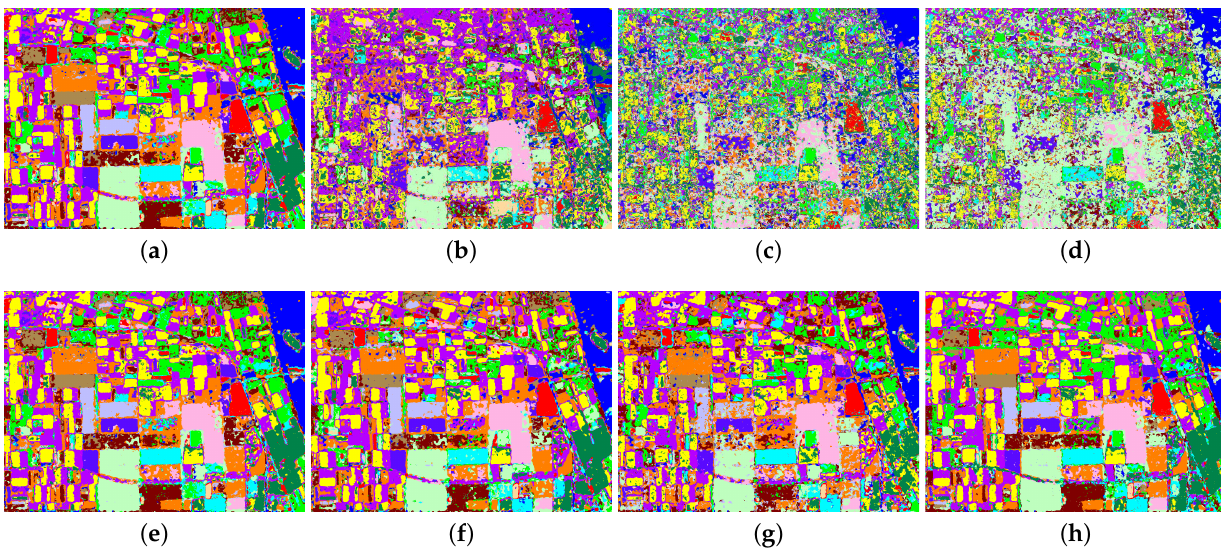
Figure 4. Prediction result of Flevoland image obtained by four classifiers on different forms of Touzi decomposition parameters, including ( a ) SVM on original parameters, ( b ) SVM on normalized parameters, ( c ) ANN on original parameters, ( d ) ANN on normalized parameters, ( e ) AE on original parameters, ( f ) AE on normalized parameters, ( g ) AEFT on original parameters, and ( h ) AEFT on normalized